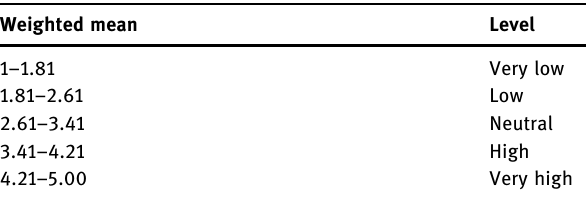
Table 2: Agreement level according to the Likert quintet scale Weighted